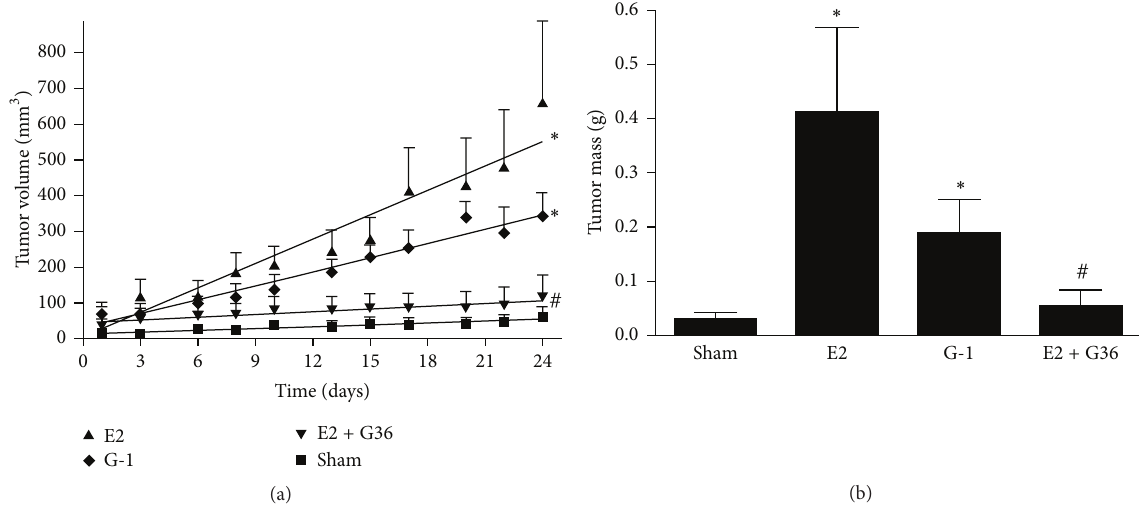
Figure 7: Inhibition of Hec50 tumor growth by GPER antagonist. Hec50 cell tumors were initiated in ovariectomized athymic mice and treated with a slow release pellet containing either no added compound (sham), estrogen (E2), G-1, or with two pellets (one of estrogen and one of G36, E2 + G36). (a) Tumor volume was measured with calipers over a 24-day period. (b) Upon sacrifice, tumors were dissected and tumor mass was determined. Data represent mean ± s.e.m. from 6–8 mice. ∗ 𝑃 < 0.05 versus sham; # 𝑃 < 0.05 versus E2 alone. Note that the tumor size for E2 + G36 was not significantly different from the